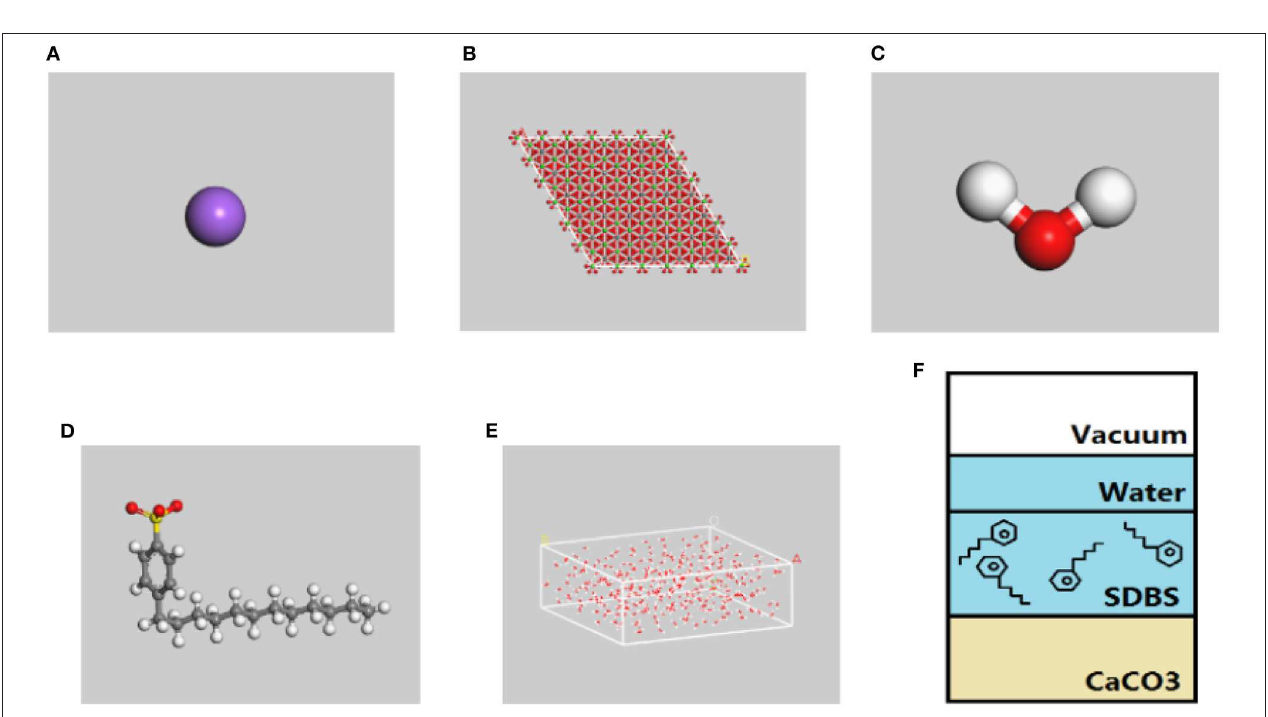
FIGURE 2 | Representation of the simulation model. Obtained by Materials studio 2017. (A) Na + ions, (B) the supercell o calcium carbonate, (C) H 2 O, (D) dodecylbenzene sulfonate ions (DBS), (E) water layer, and (F) test model.